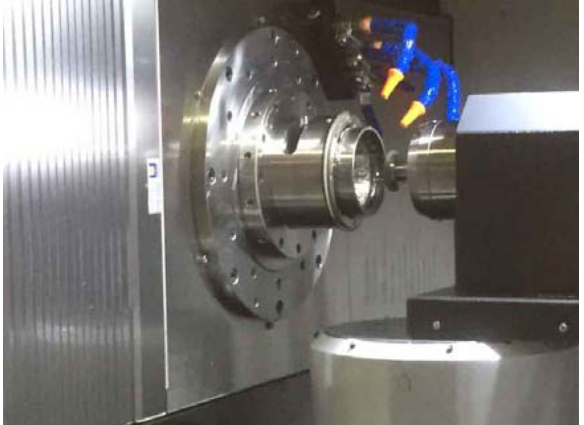
Figure 9. Grinding process.